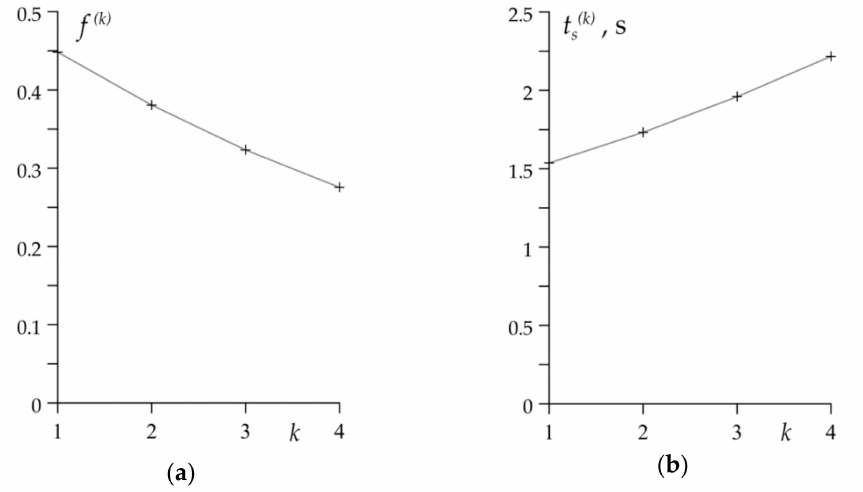
( k ) ( k ) ; ( b ) stop time t s for disc brake in each braking 0